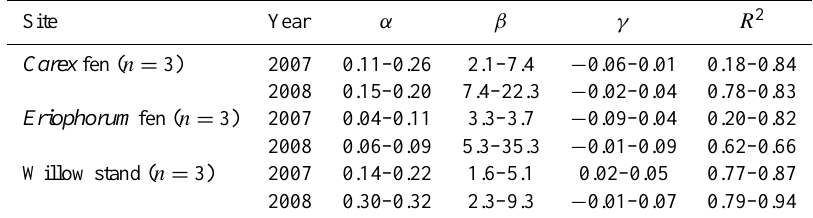
Table 1. Summary of the empirical models used to generate the seasonal CH 4 flux estimates for the different wetland land cover types at the Seida study site. These seasonal estimates are based on chamber fluxes measured during the snow-free period. Models were fitted separately for each measurement